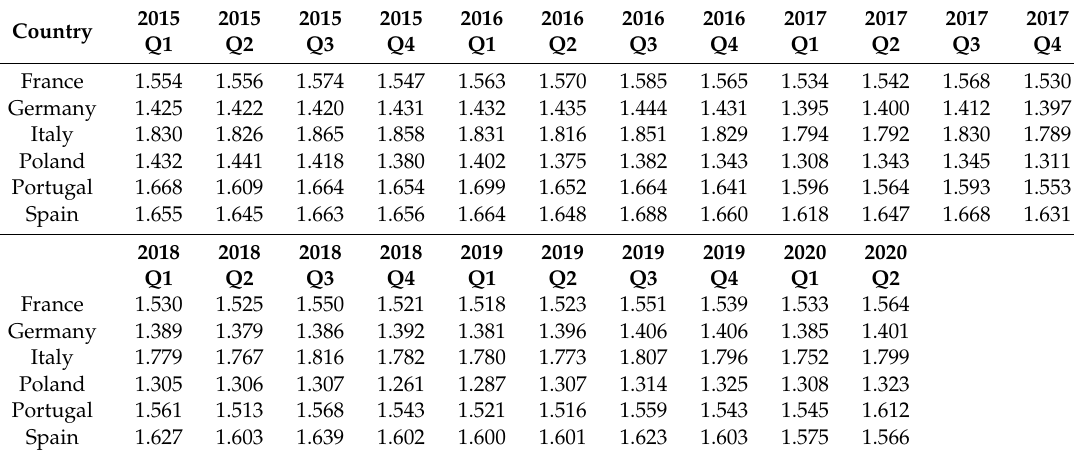
Table 3. Fiscal multipliers, own work, source: Eurostat.